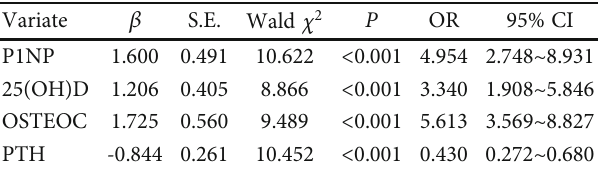
Table 4: Relationship between biochemical indexes of bone metabolism and incidence of osteoporotic lumbar fractures.